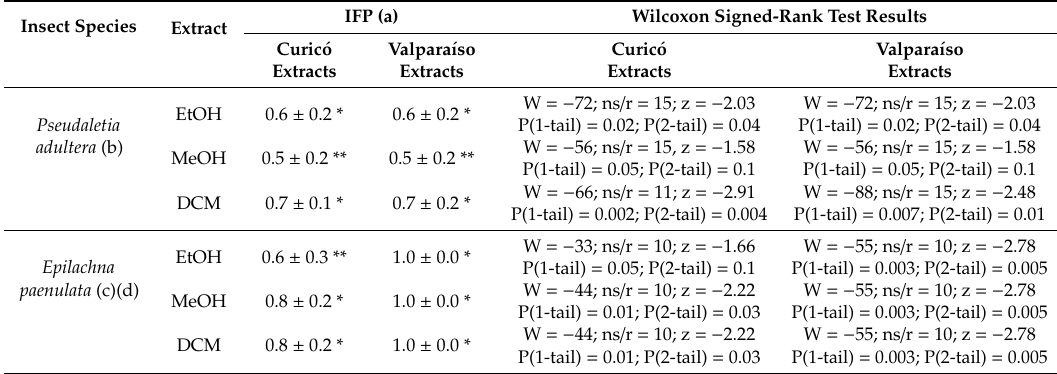
Table 4. Antifeedant activity presented as the index of feeding preference (IFP) on P. adultera and E. paenulata larvae of the P. maculosa leaf extracts from Curic ó and Valpara í so at the end of the assays. Results are shown as mean ± standard error